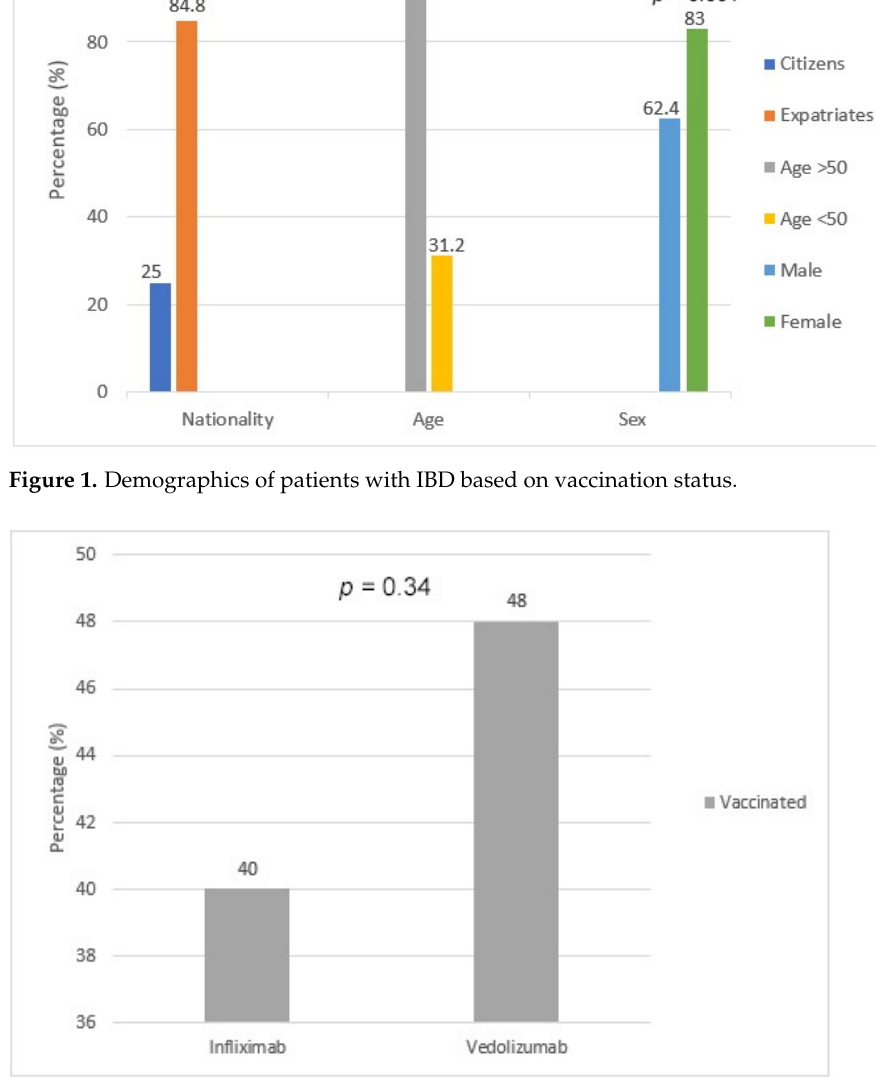
Figure 2. Vaccination status of patients with IBD based on type of biologic therapy.